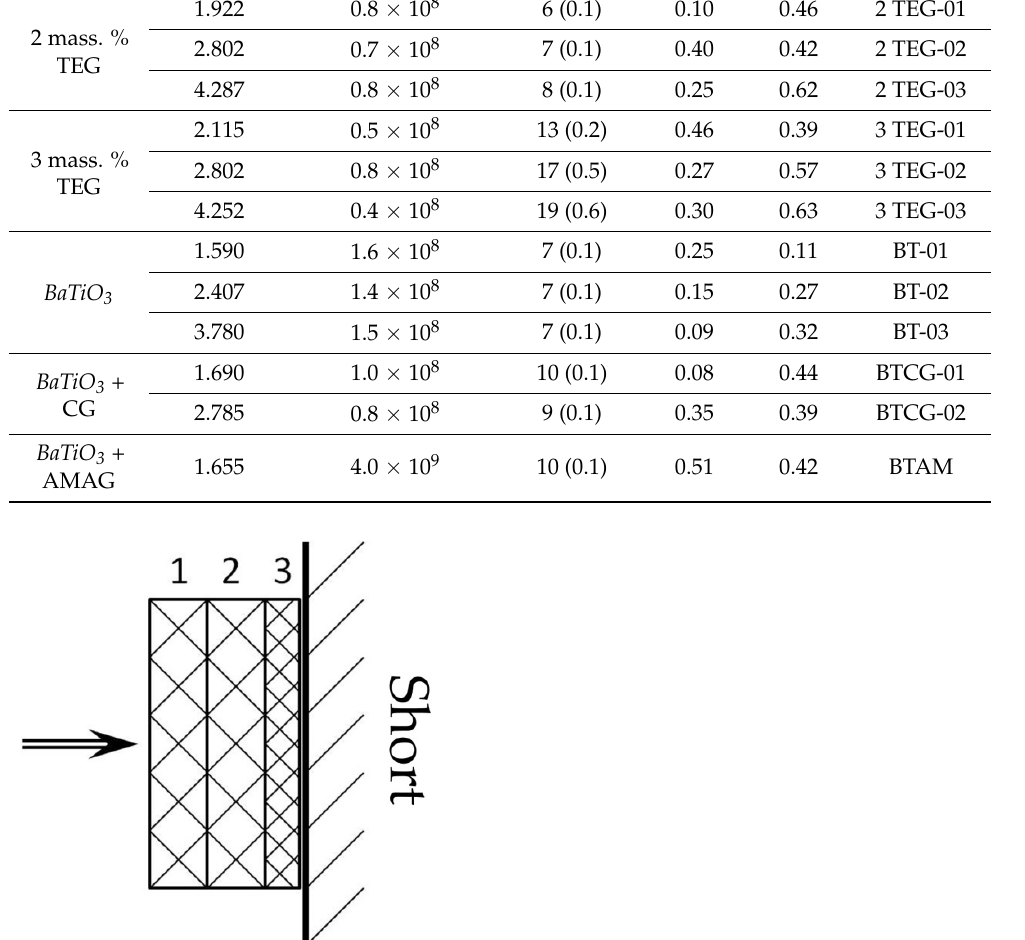
Figure 38. Scheme of a three-layer composite coating in a short-circuited path. (1) and (2) are the absorbing composite layer; (3) is the underlying dielectric layer. The arrow shows the direction of an incident wave.